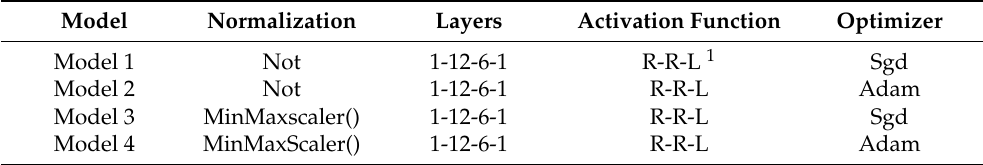
Table 1. Model parameters of the sensitivity